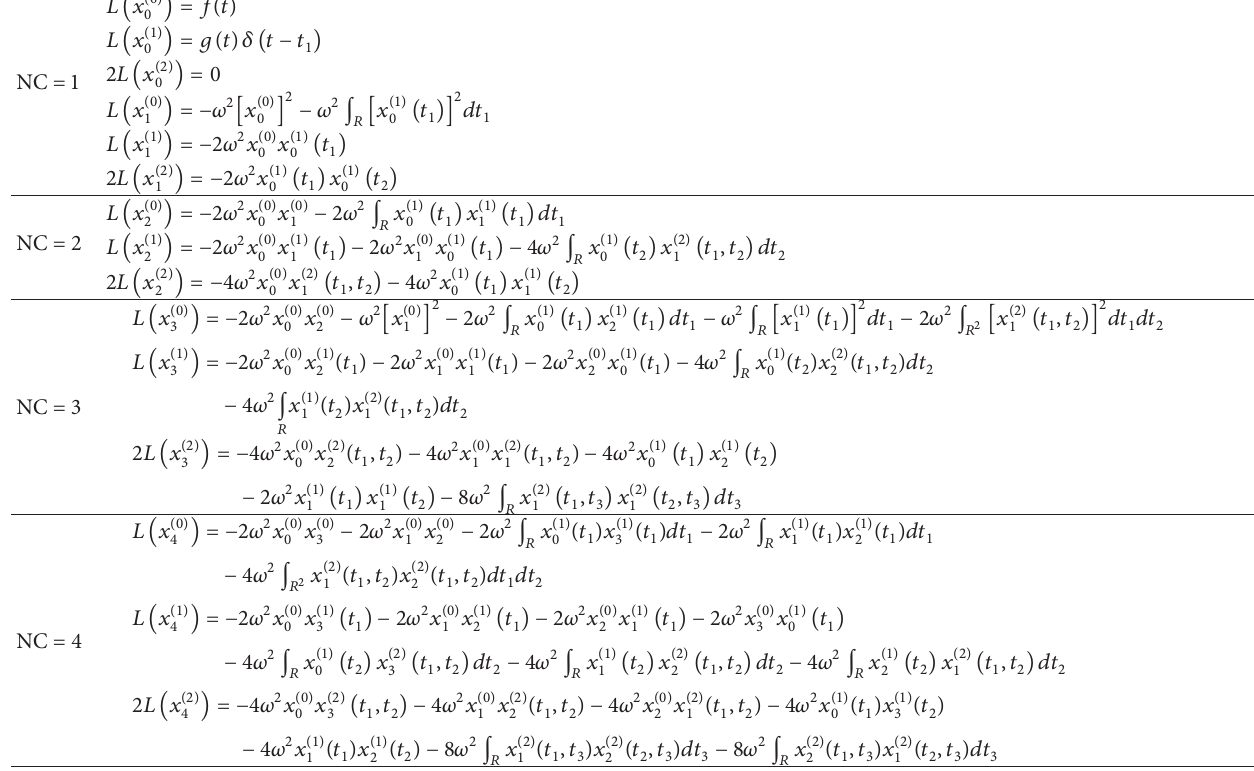
Table 2: The equivalent deterministic systems for second-order approximation with different number of corrections (NC). ) = 𝑓(𝑡) 𝐿 (𝑥 (0) 0 ) = 𝑔(𝑡)𝛿(𝑡 − 𝑡 𝐿 (𝑥 (1) 1 0 NC = 1